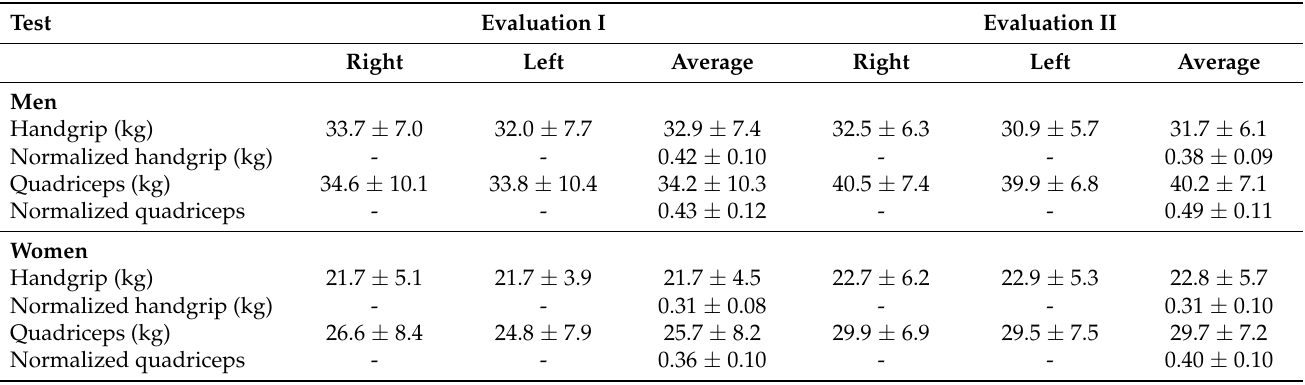
Table 3. Mean and standard deviation of the mean of the muscle strength on the handgrip test and the quadriceps dynamometry of 43 patients at the first evaluation, and 40 patients at the second